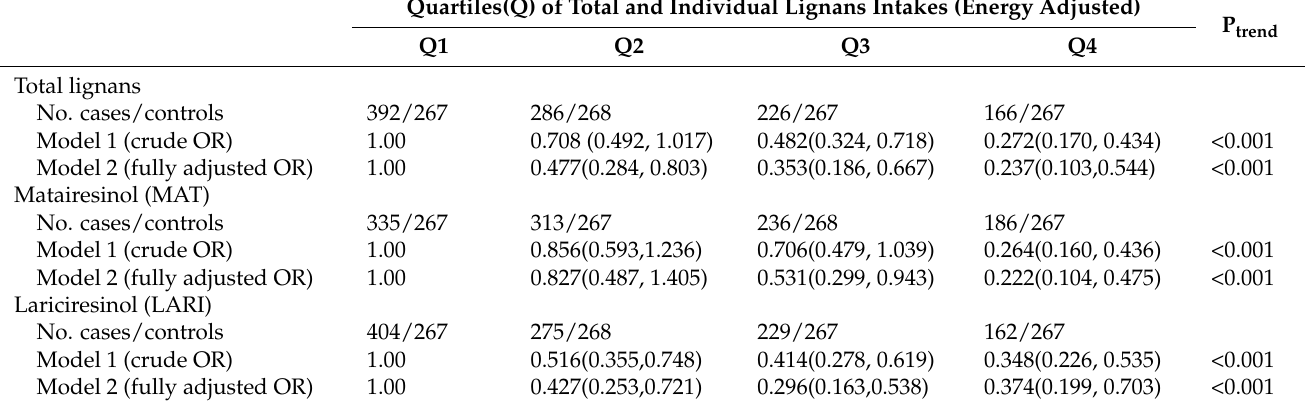
Table 3. Odds ratios (ORs) and 95% confidence intervals (CIs) of hip fracture risk according to quartiles of dietary total and individual lignans intakes in Chinese older adults. Quartiles(Q) of Total and Individual Lignans Intakes (Energy